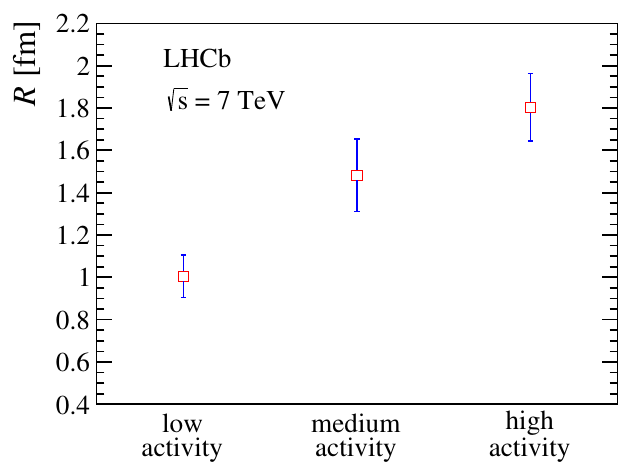
Figure 3 . Correlation radius R as a function of activity. Error bars indicate the sum in quadra- ture of the statistical and systematic uncertainties. The points are placed at the centres of the activity bins.